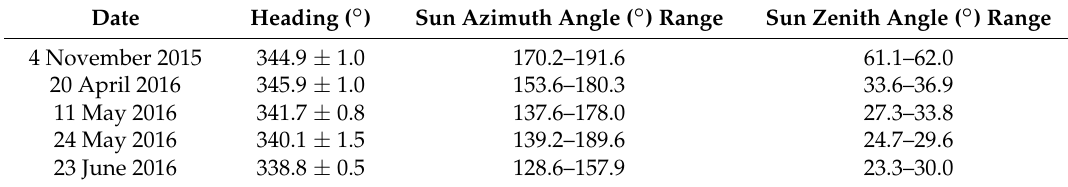
Table 2. Flight heading and illumination characteristics for the 5 image-acquisition dates. All flights were conducted at an approximate altitude of 1000 m